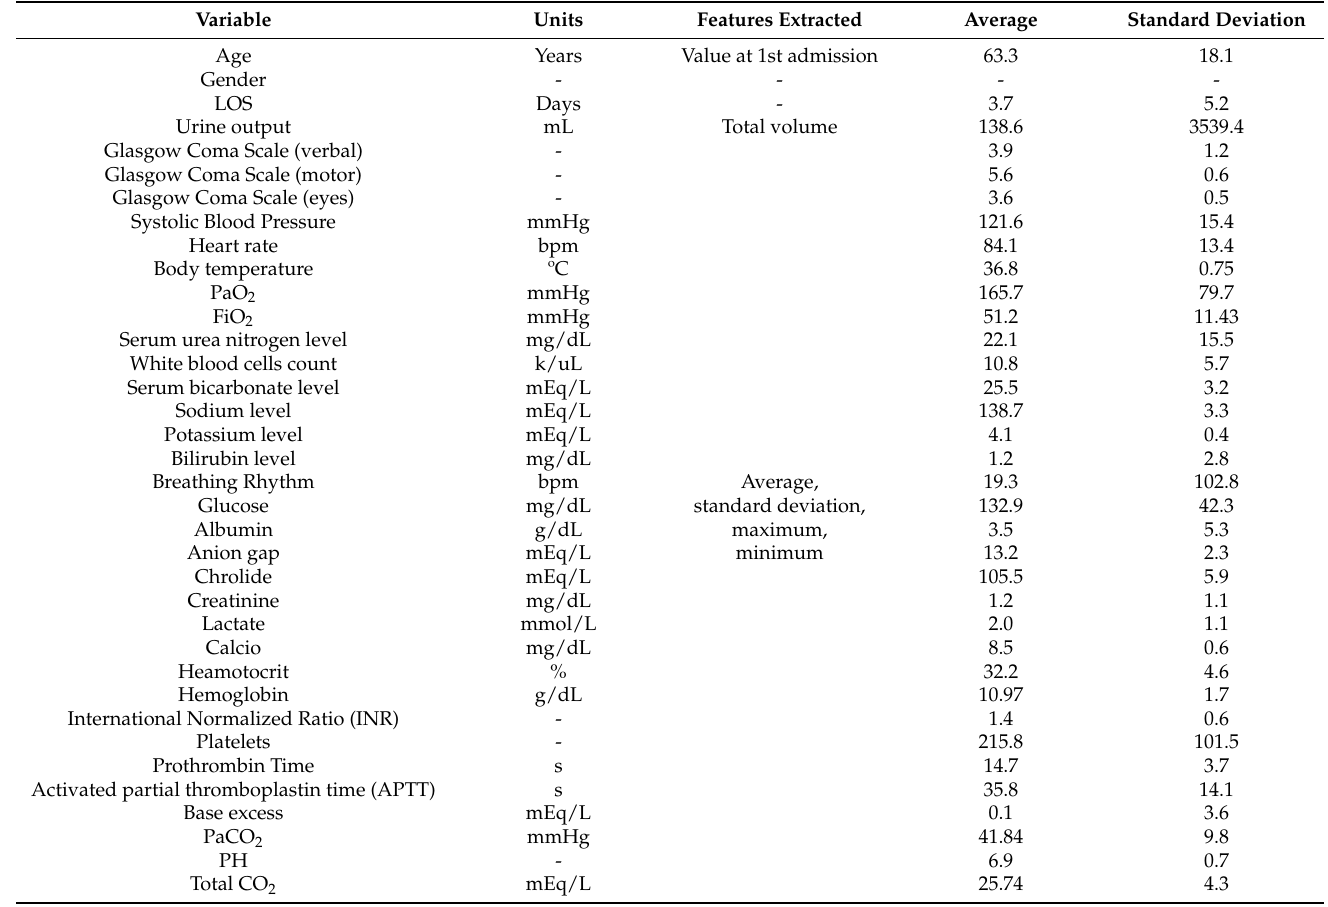
Table 2. Variables used and features extracted to feed the predictor